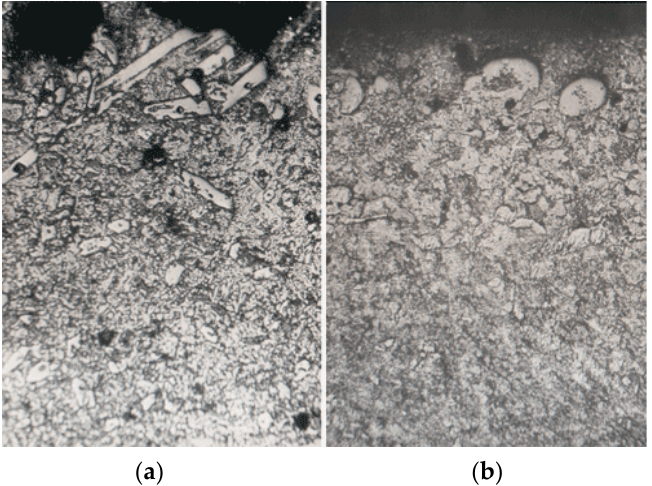
Figure 15. Microstructure of plasma fused coatings: ( a )—with initial particles of the hardening component (TiCr)B2, ×400, ( b )—spheroidized particles. component (TiCr)B2, × 400, ( b )—spheroidized